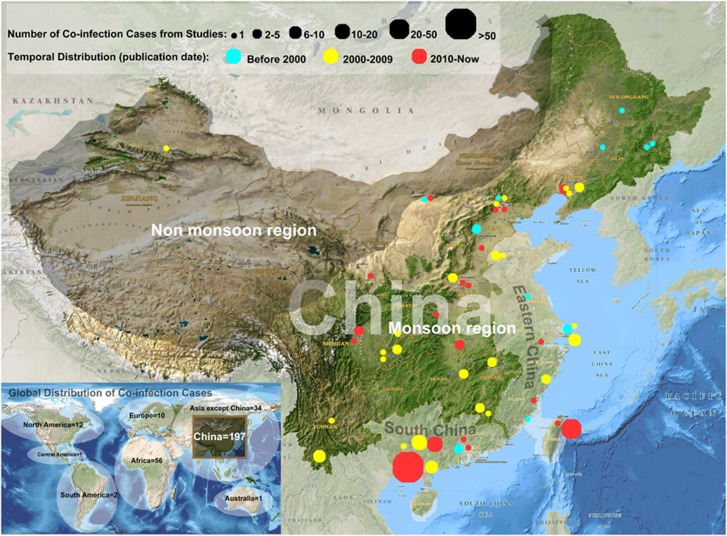
Nationwide distribution of tuberculosis (TB)/cryptococcosis co-infection cases from 1965 to 2016.